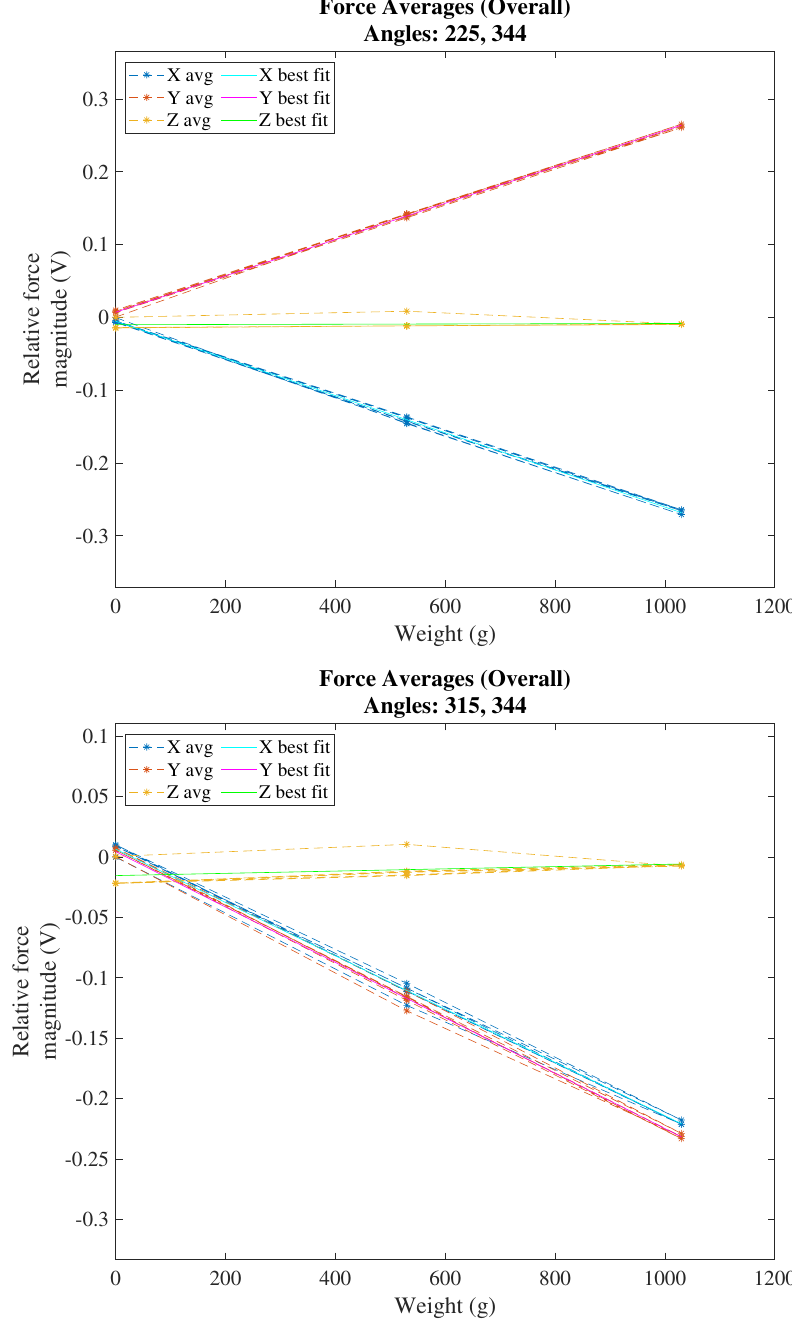
Figure A4. Voltage response to 3D calibration loading in different